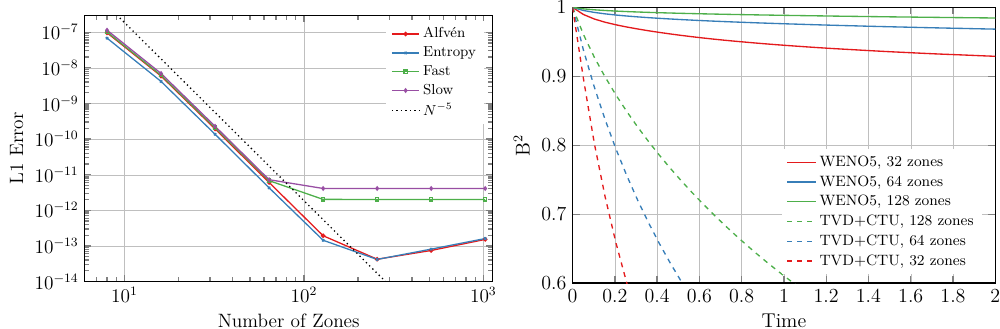
Figure 1. Left : L1 error of the wave convergence test from in one dimension Gardiner and Stone [19]. Alfvén mode in red, entropy mode in blue, fast mode in the green and slow mode in purple. Right : Evolution of magnetic energy in the advection of a field loop test.